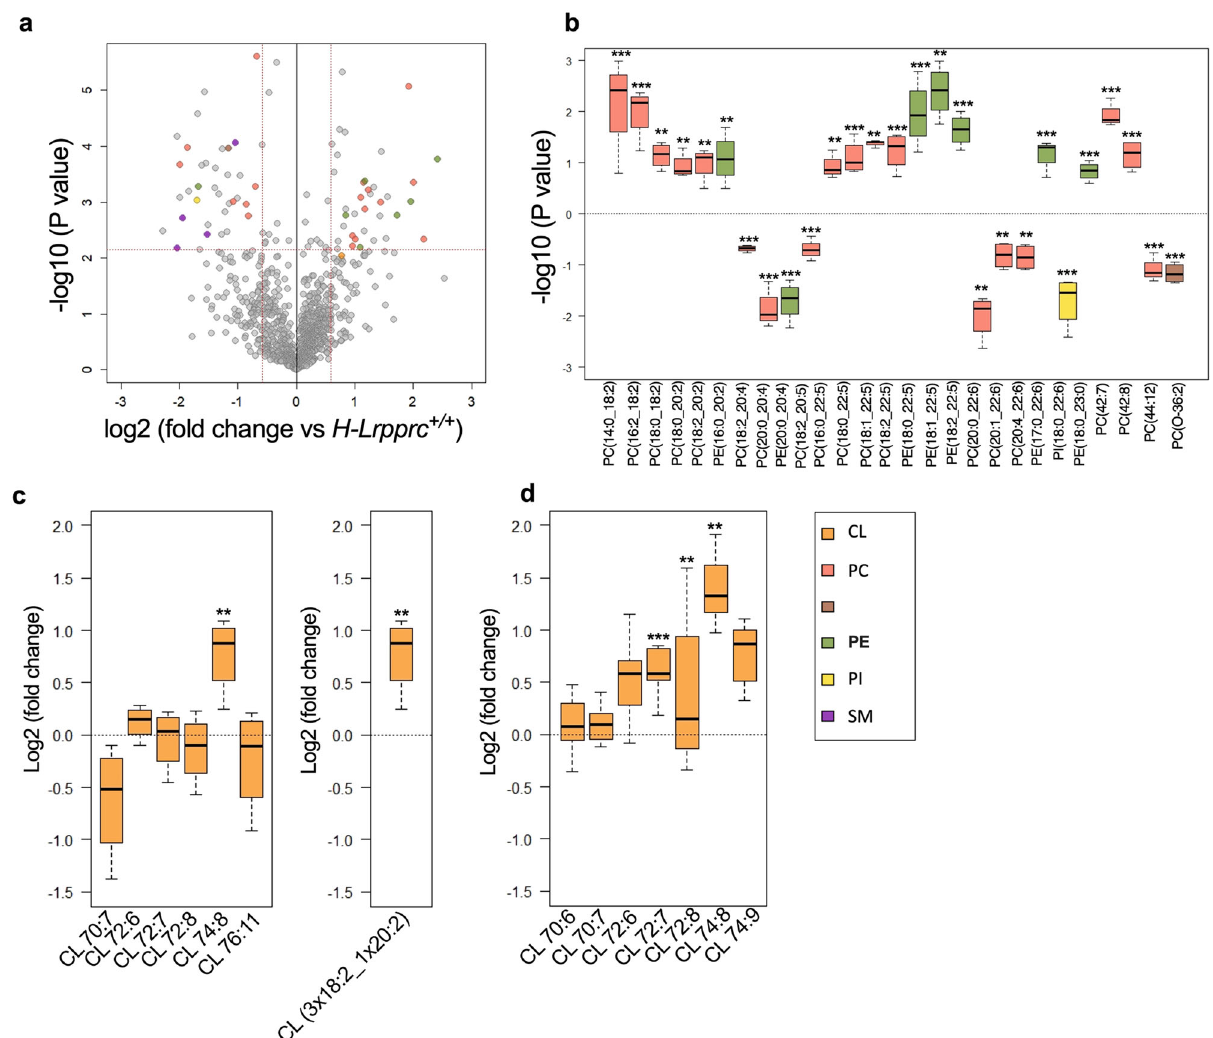
Fig. 4 Impact of LRPPRC de fi ciency on mitochondrial membrane lipids. Comprehensive lipidomics of digitonin solubilized mitochondrial extracts ( a , b ) and targeted data mining of cardiolipin (CL) in digitonin-extracts ( c ) or isolated mitochondria ( d ). a Volcano plot from LC-QTOF-based untargeted lipidomics of digitonin solubilized mitochondria from H- Lrpprc + / + and H- Lrpprc − / − ( n = 4 per group). The x axis represents fold changes (FCs) of MS signal intensity values for all these features in H- Lrpprc − / − vs. H- Lrpprc + / + (log2) and the y axis represents p values ( − log10). A corrected p value ( Q - value) threshold of 0.05 (corresponding to a P -value of 0.007) and a relative FC of 1.5 were used, leading to 69 signi fi cantly discriminant features among the 1176 MS features on which 31 were annotated. b Box plot of 27 selected lipids signi fi cantly discriminating H- Lrpprc − / − from H- Lrpprc + / + , and annotated using MS/MS analysis. The midline represents the median fold change vs. H-Lrpprc + / + , the box represents the interquartile range (IQR) between the fi rst and third quartile, and whiskers represent the lowest or highest values. c , d Box plot of CL species annotated by MS/MS analysis in the digitonin-extracts ( c ) and in isolated mitochondria ( d ). Differences are shown according to a Q value of 0.056 (corresponding to a P -value of 0.009); (*** P < 0.01, ** P <